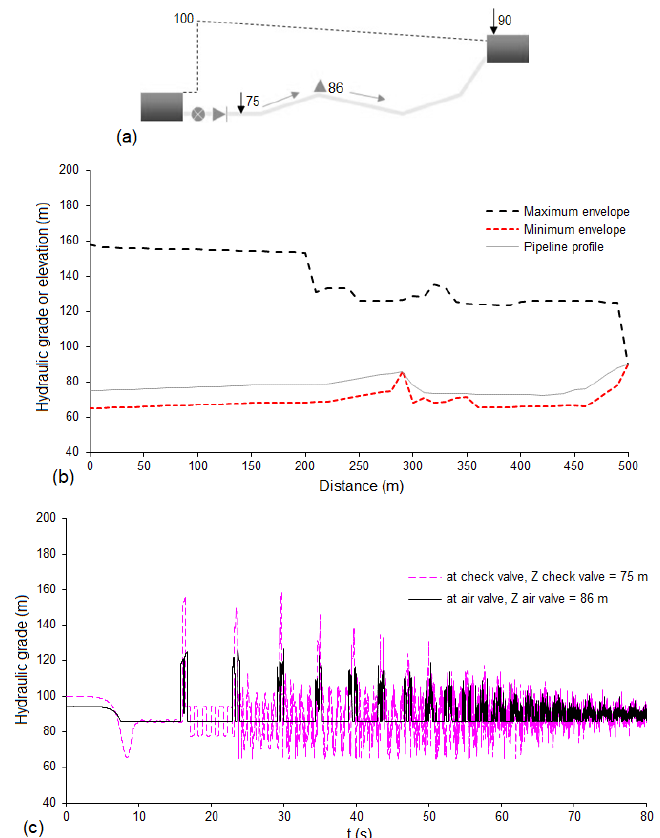
Figure 15. Pump trip scenario for water pipeline: ( a ) general characteristics of the line; ( b ) hydraulic grade envelopes (maximum and minimum); ( c ) hydraulic grade variation at the check valve (next to the pumping system) and at the air